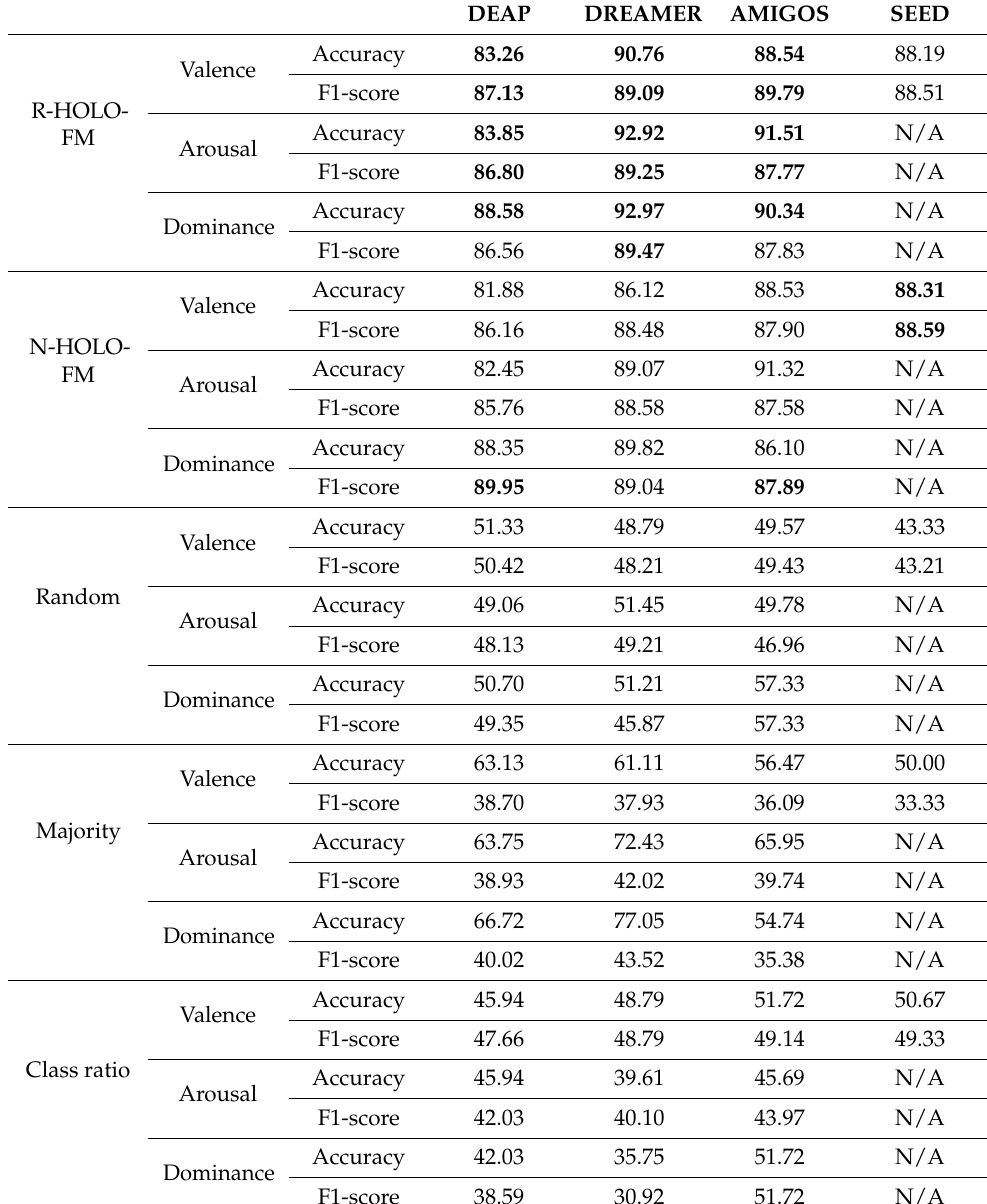
Table 3. Accuracy and F1-score for proposed and baseline methods in 3D emotional space per dataset.